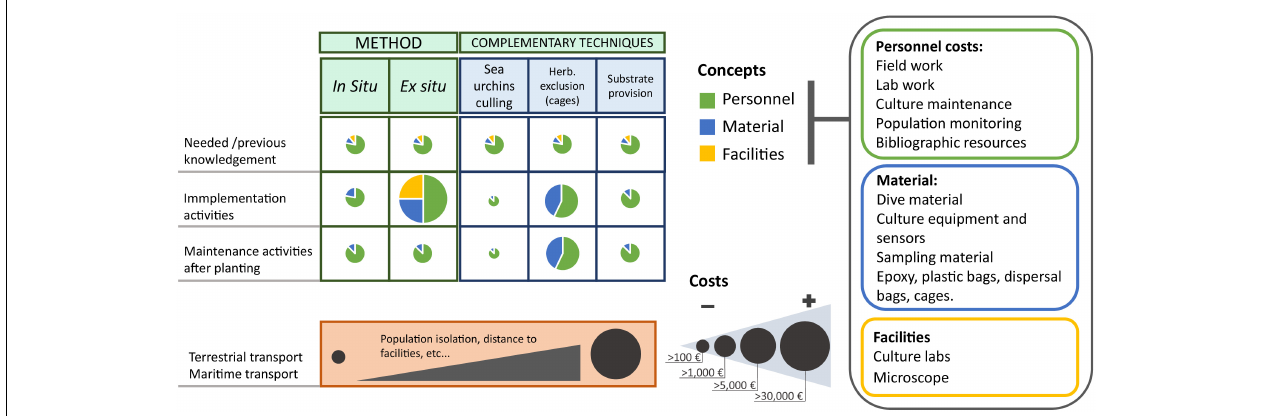
FIGURE 3 | Composition of restoration costs (€) for fucalean macroalgal forests, according to the restoration method and the complementary techniques. The size of the circle represents the cost amount, and the color and size of the different sectors represent the contribution of the different concepts (e.g., personnel, material, and facilities) to the total cost for previous knowledge acquisition, the implementation activities, and the maintenance activities to be performed after planting. Maritime and terrestrial transport are also